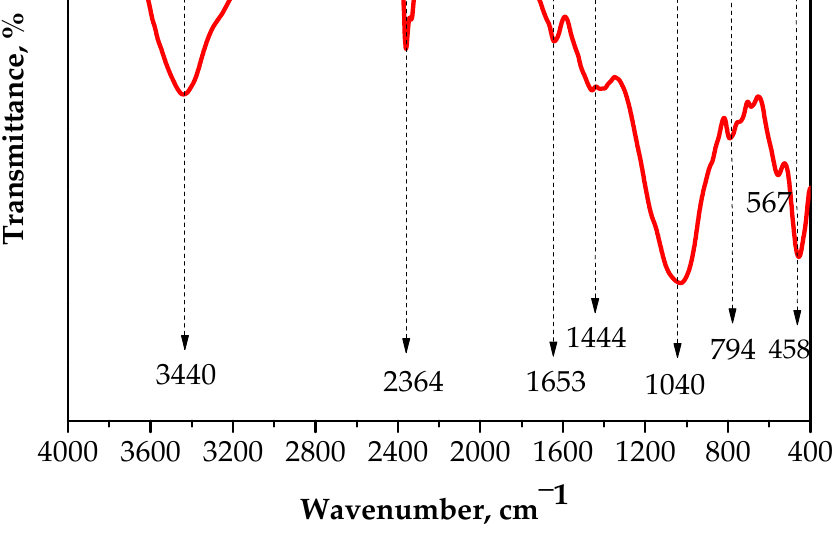
Figure 3. FTIR spectra.